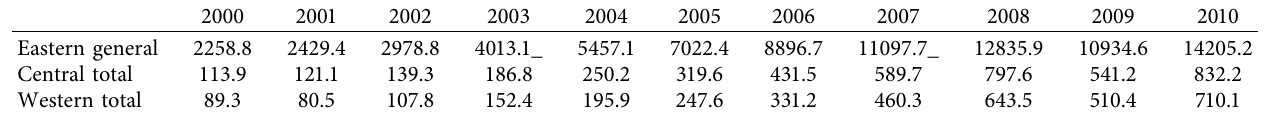
Table 1: China’s total exports by region (2000–2010).